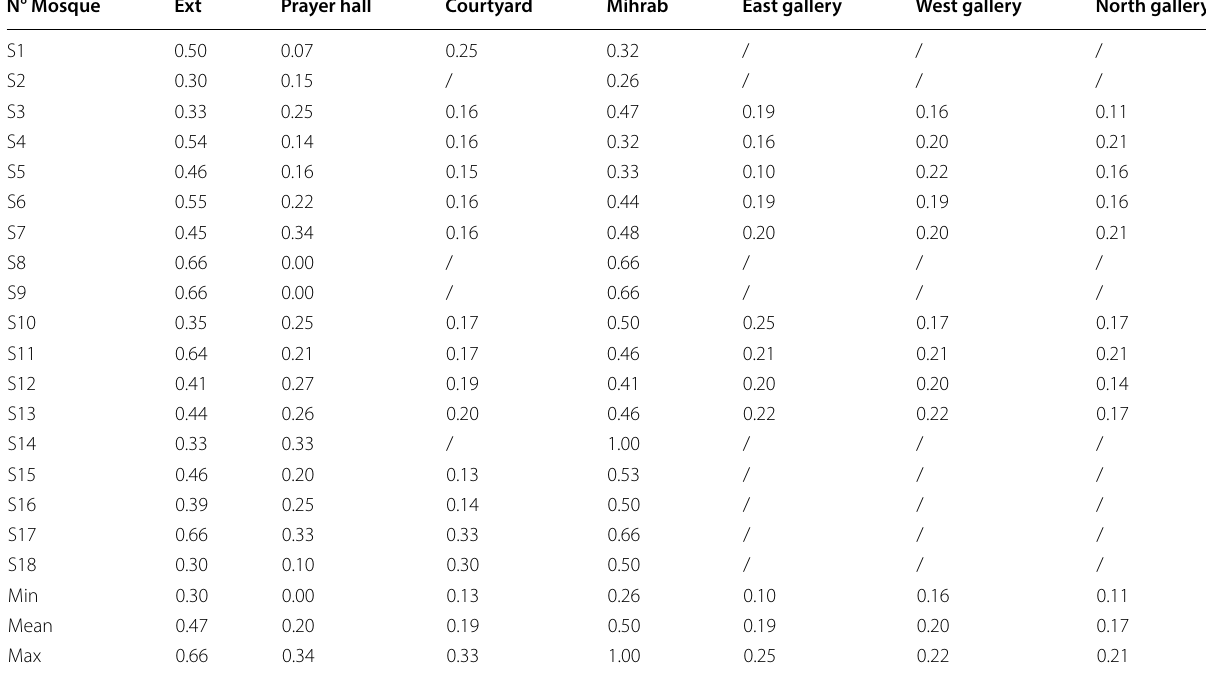
Table 5 Integration of prayer and transition spaces in mosques N°